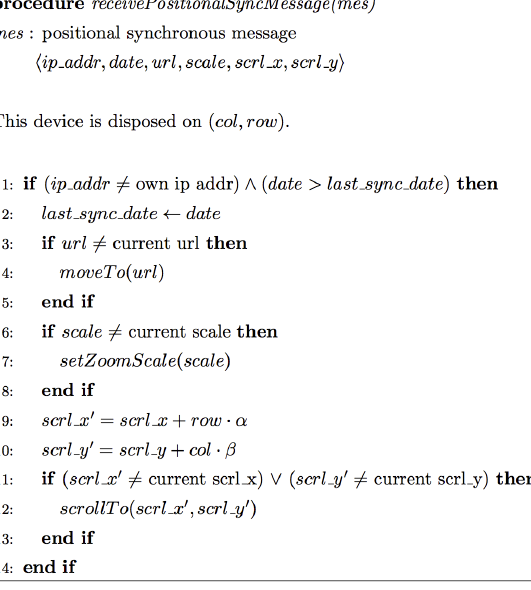
Fig. 6. The procedure that is called when the system re- ceives a synchronous